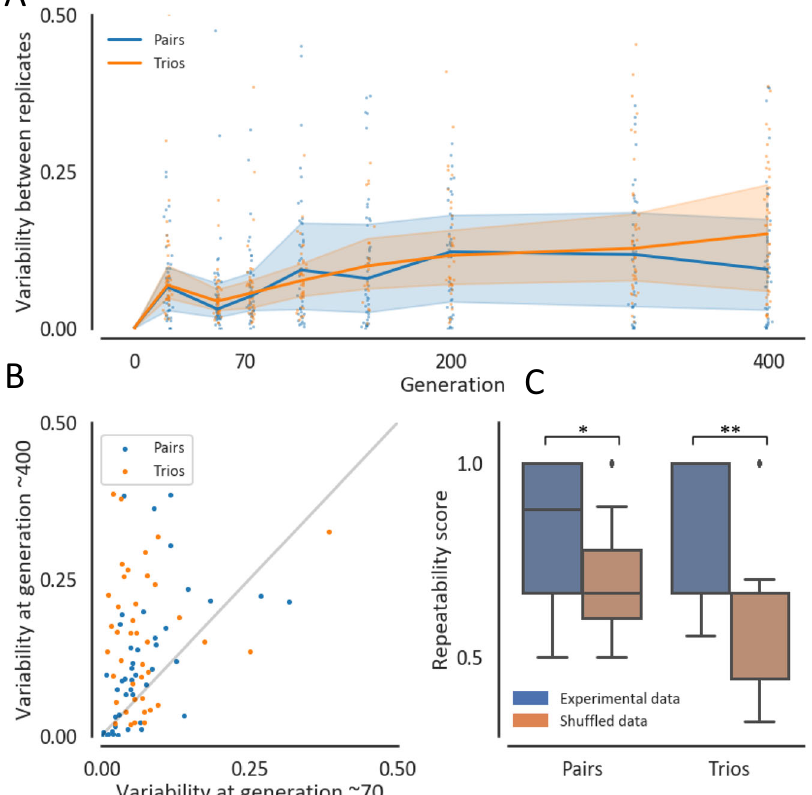
Fig. 3 Variability between replicate communities increases during ~400 generations, yet remains signi fi cantly non-random. A Variability in community composition between replicate communities is quanti fi ed by the mean Euclidean distance of each replicate from the medoid replicate normalized to the ffiffiffi p maximal distance between two communities composed of n species ( n ). Blue and orange lines and shaded-areas are the medians and interquartile ranges across all pairs and trios, respectively. Dots denote the variability of speci fi c communities across replicates. B Variability at generation ~400 against ffiffiffi p ~70, measured as the mean distance from medoid normalized to the maximal distance between two communities composed of n species ( n ). Each dot represents a pair (blue) or a trio (orange). C Distribution of repeatability scores of the experimental data (38 pairs, 31 trios) and a random null model. The repeatability score is the frequency of replicates in which the same species increased its abundance by the biggest factor between generation ~70 and ~400. Communities that had missing replicates and therefore had less than 3 replicates for either generation ~70 or ~400, were removed from this analysis. The brown boxes represent the distribution of 2000 iterations of a shuf fl ed model, where the values of changes in relative abundances between generation ~70 and ~400 of all species are pooled and are subsequently randomly assigned (for pairs and trios separately) to any species in any community in the dataset. Boxes indicate the quartiles and whiskers are expanded to include values no further than 1.5X interquartile range. * p value = 0.05, ** p value <0.005. P values indicate the frequency of iterations were the shuf fl ed data ’ s mean repeatability score was at least as high as the experimental data ’ s mean. Source data are provided as a Source Data fi